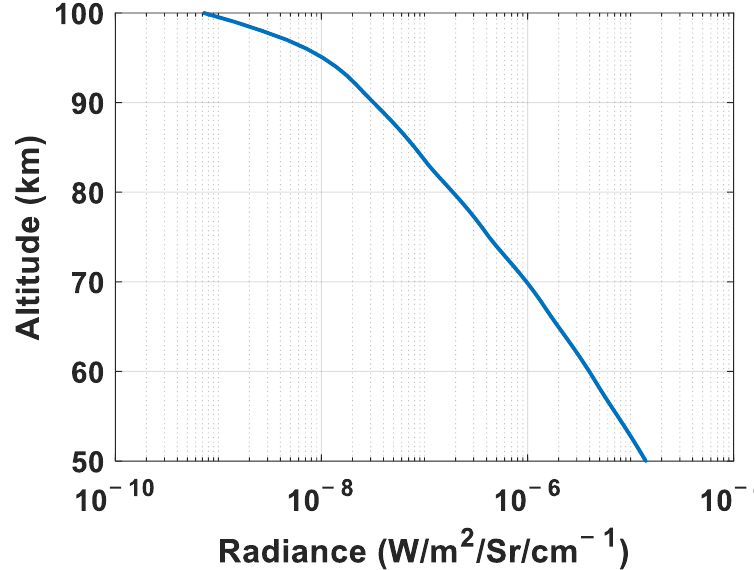
Figure 5. The simulation result of the background radiance profile.